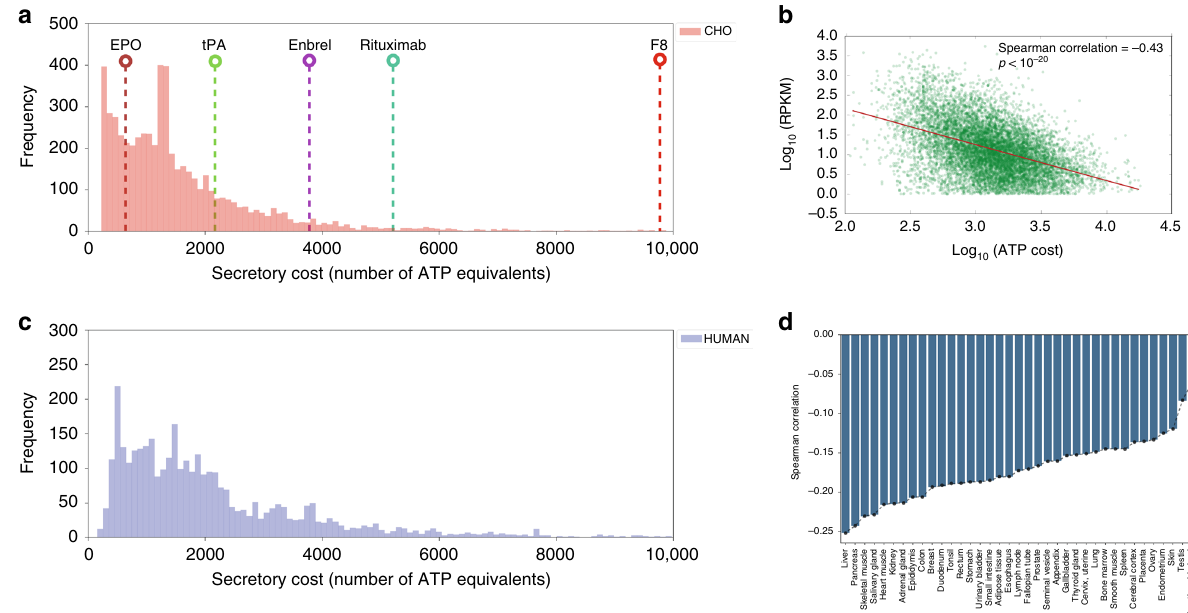
Fig. 1 Mammalian secretory cells preferentially suppress more expensive proteins. The bioenergetic cost of each secreted CHO ( a ) and human ( c ) protein was computed. The bioenergetic costs of fi ve representative biotherapeutics produced in CHO cells are shown for comparison purposes (see Table 1). b Scatter plot and Spearman correlation of gene expression measured by ribosomal pro fi ling and protein cost (in number of ATP per protein) in CHO cells from Kallehauge et al. 12 during the early exponential growth phase of culture. d Spearman correlations between ATP cost and gene expression levels (measured by RNA-Seq) across human tissues 1,58,59 . Gene transcription levels from the Human Protein Atlas were analyzed against the ATP cost of producing the translated proteins. All p -values associated with each correlation are<1×10 -20 . Highly secretory tissues show the strongest negative correlation of secreted protein cost vs. mRNA expression levels. RPKM = reads per kilobase of transcript per million. Source data are provided as a Source Data fi